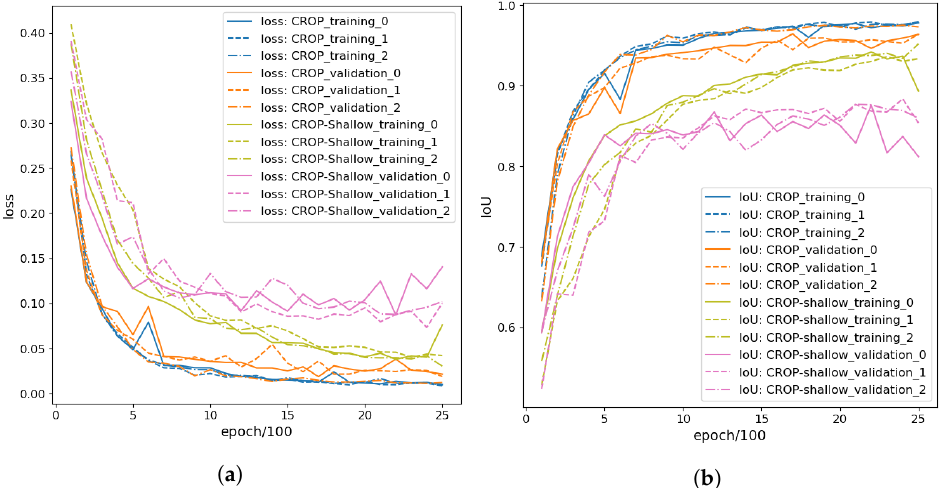
Figure 5. Comparing the training processes of CROP and CROP-Shallow through three experiments for each, numbered from 0 to 2. They were conducted for 2500 epochs with the training dataset (80%: 137) and the validation dataset (20%: 35) of Data_Fruit . ( a ) Losses for epoch 100–2500. ( b ) IoUs for epoch